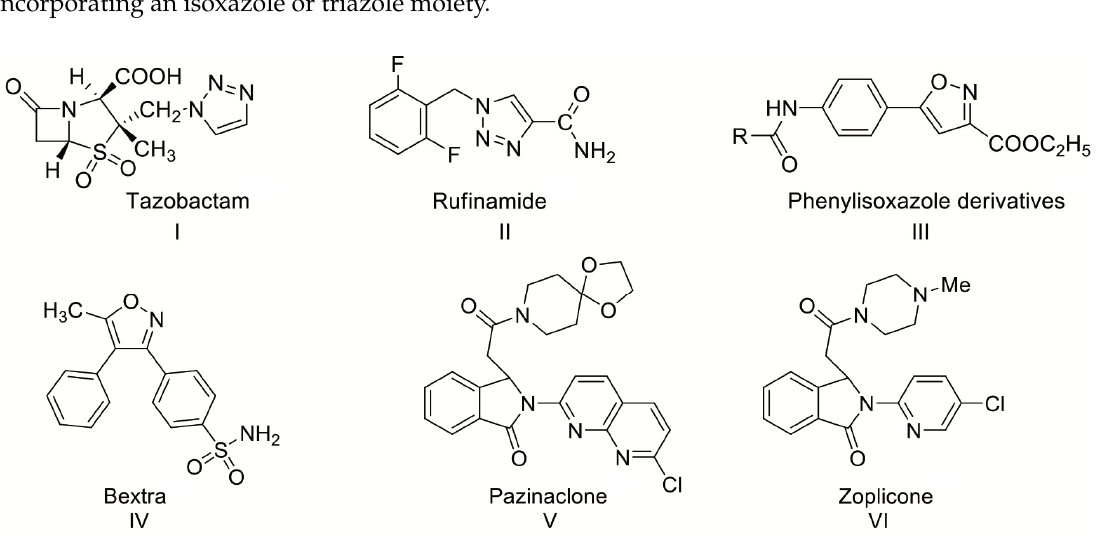
Figure 1. Structures of isoxazoles, triazoles and 3-substituted dihydroisoindolin-1-ones exhibiting biological or pharmaceutical activities